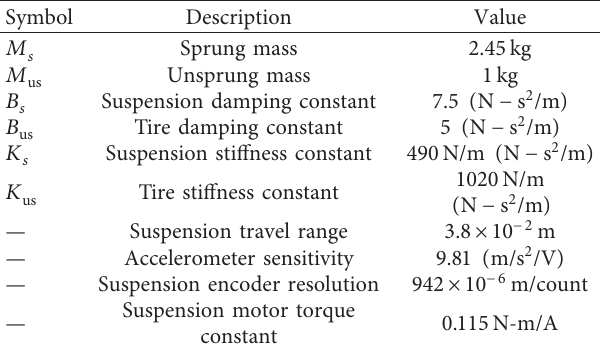
Figure 1: Free body diagram of the quarter-car ASS. Table 1: Quarter-car active suspension system plant